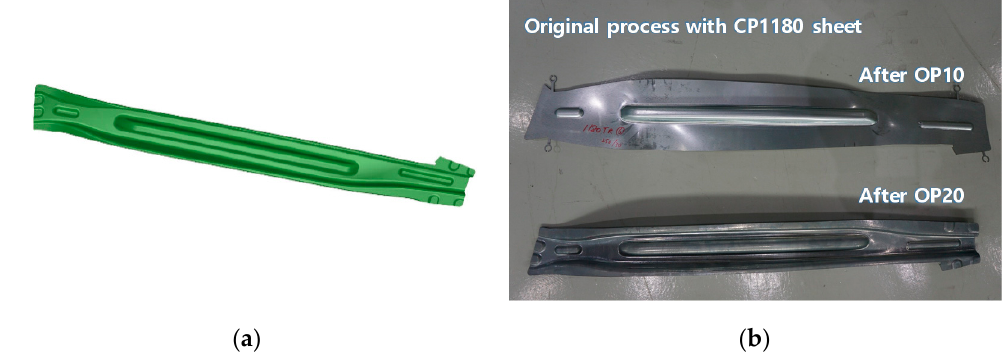
Figure 11. Target door impact beam: ( a ) Modeling of the target door impact beam; ( b ) Original process (OP10 and OP20) with CP1180 sheet.